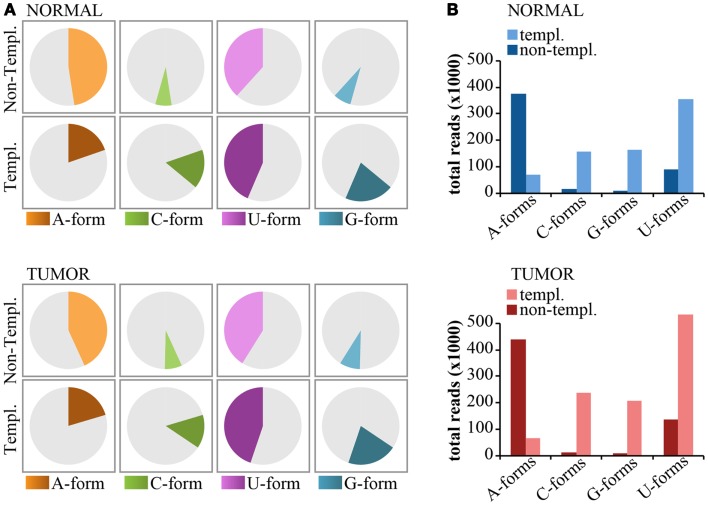
Nucleotide distribution of 3′-end non-templated modifications. (A) Pie charts show the frequency of 3′ modifications, distinguished according the nucleotide type (A, G, C, U) subdivided in templated or non-templated 3′-end isomiRs. (B) The bar graphs show the expression levels (total read counts) of the same species as in (A).